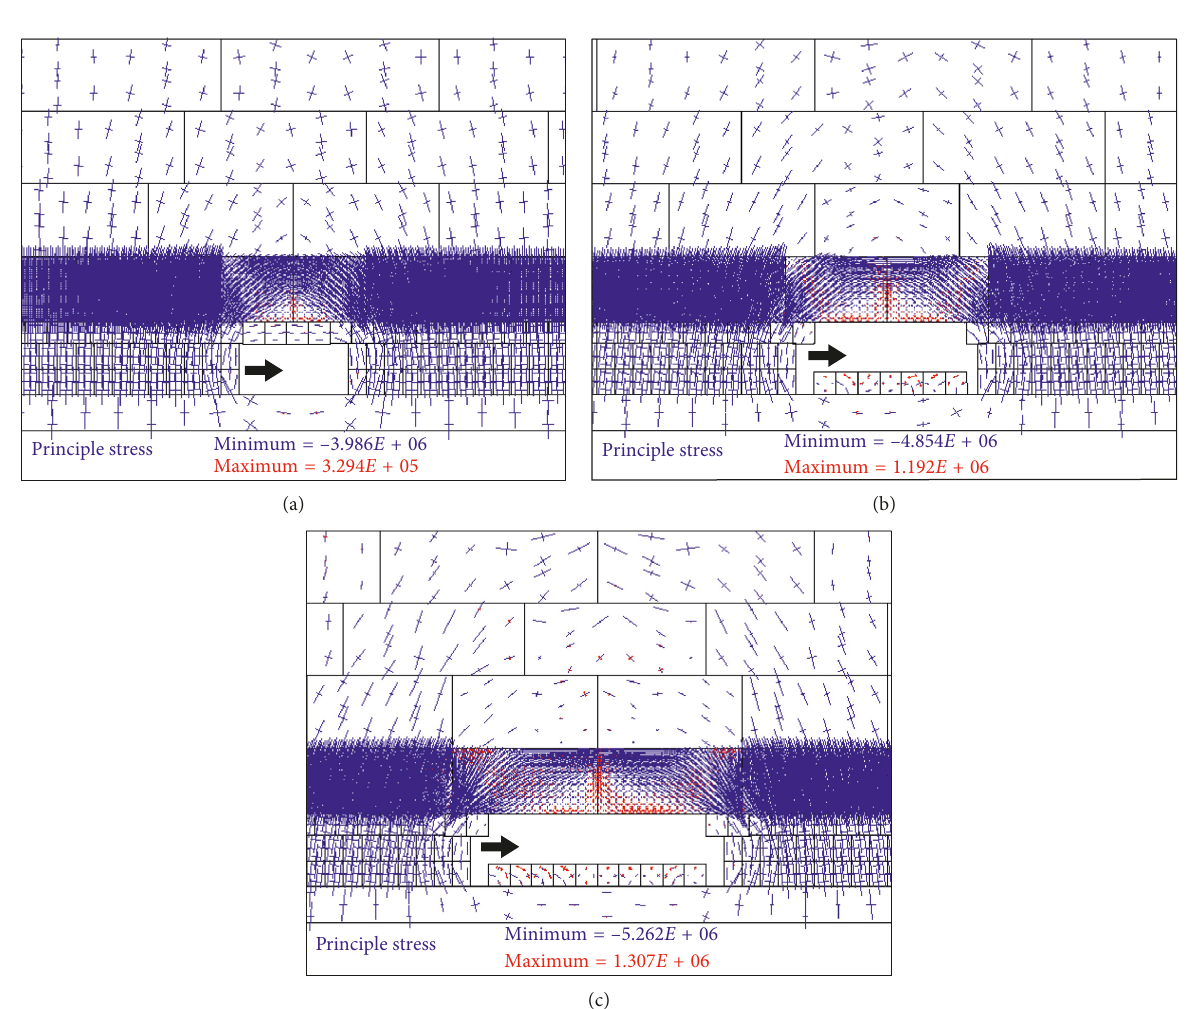
Figure 11: Symmetric pressure-arch structure of two key blocks with different block sizes. (a) L � 10m. (b) L � 14m. (c) L �